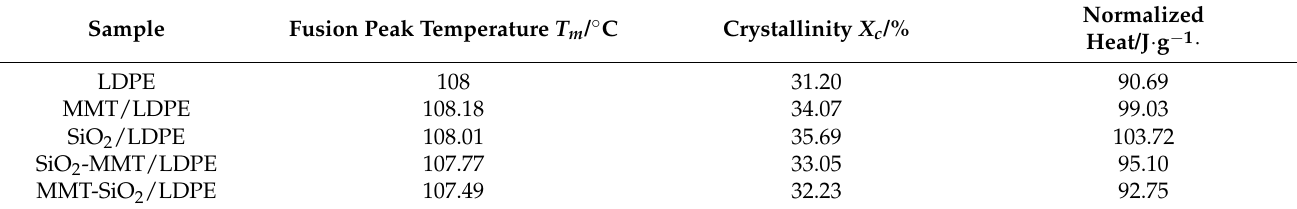
Table 1. Fusion peaks and crystallinity of